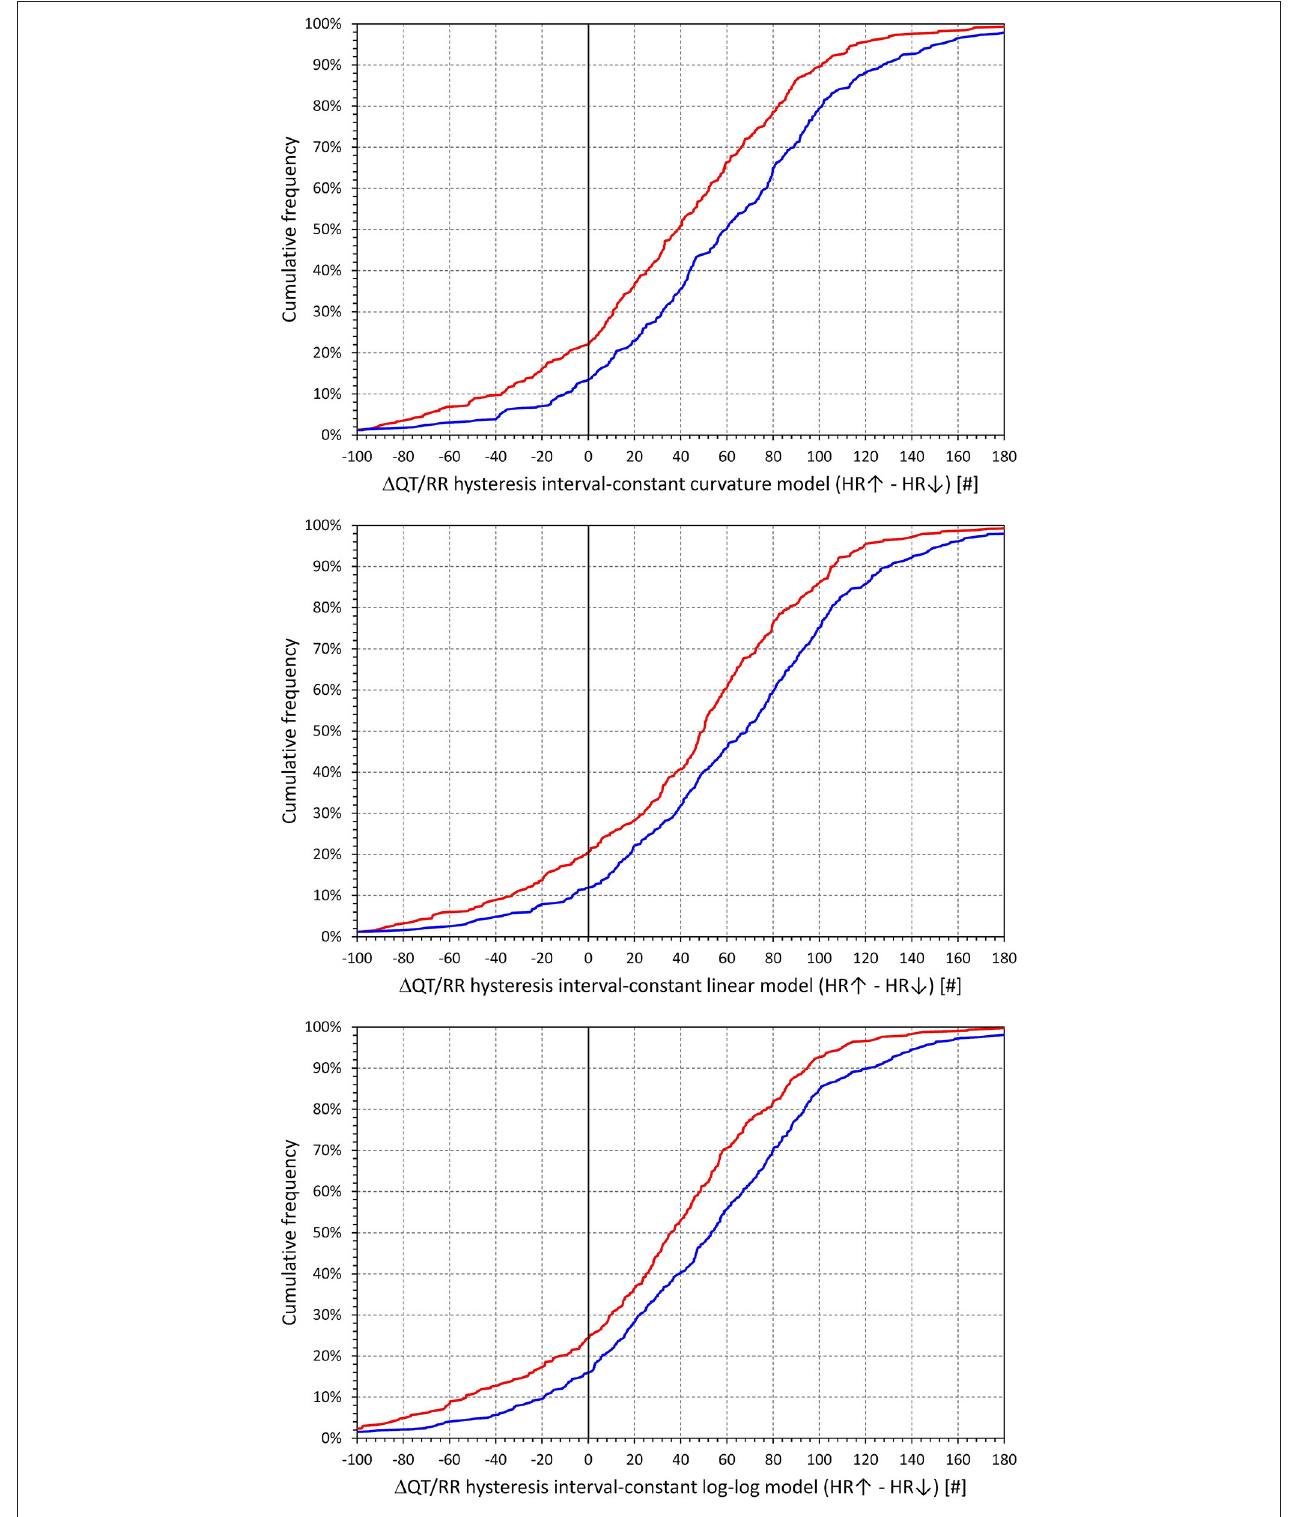
FIGURE 12 | Cumulative densities of subject-specific differences among hysteresis interval constants during heart rate acceleration and deceleration. The top, middle, and bottom panels show the differences for the curvature, linear, and log-log QT/RR H models, respectively. In each panel, the red and blue lines correspond to females and males,